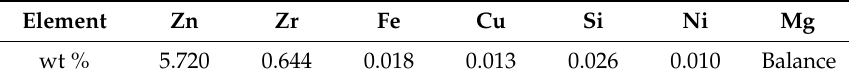
Table 1. Composition of ZK60 alloy used in this